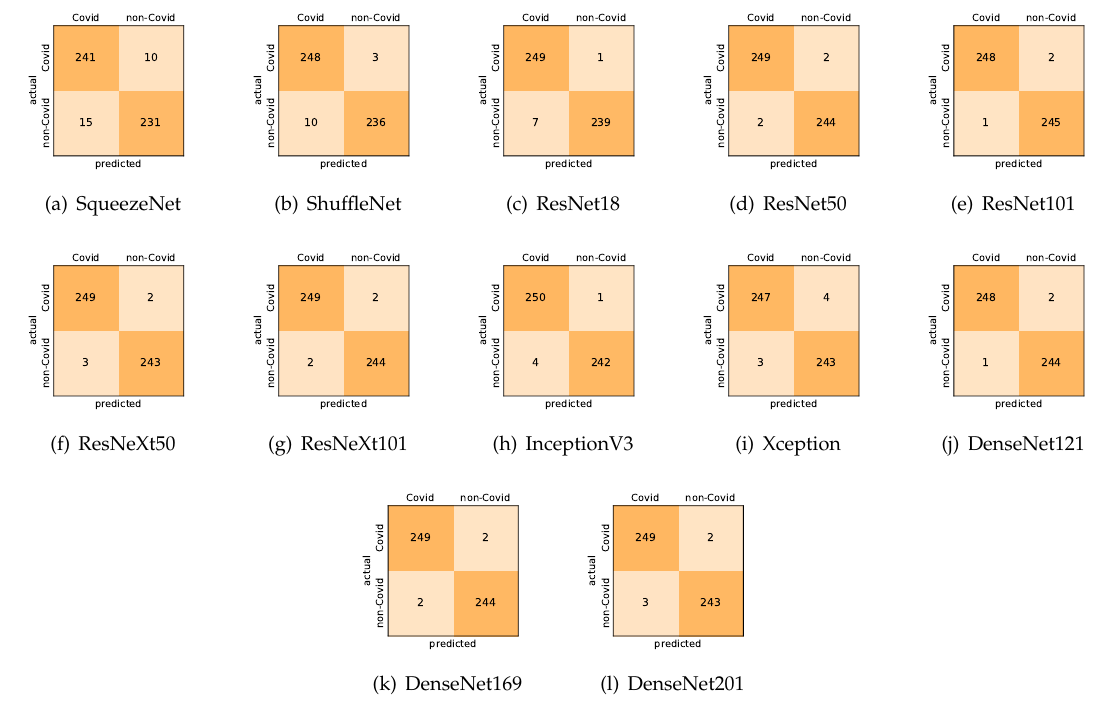
Figure 9. Confusion matrices for the different deep CNN models. These results are the average counts of the five models obtained by stratified 5-fold cross-validation on the SARS-CoV-2 CT